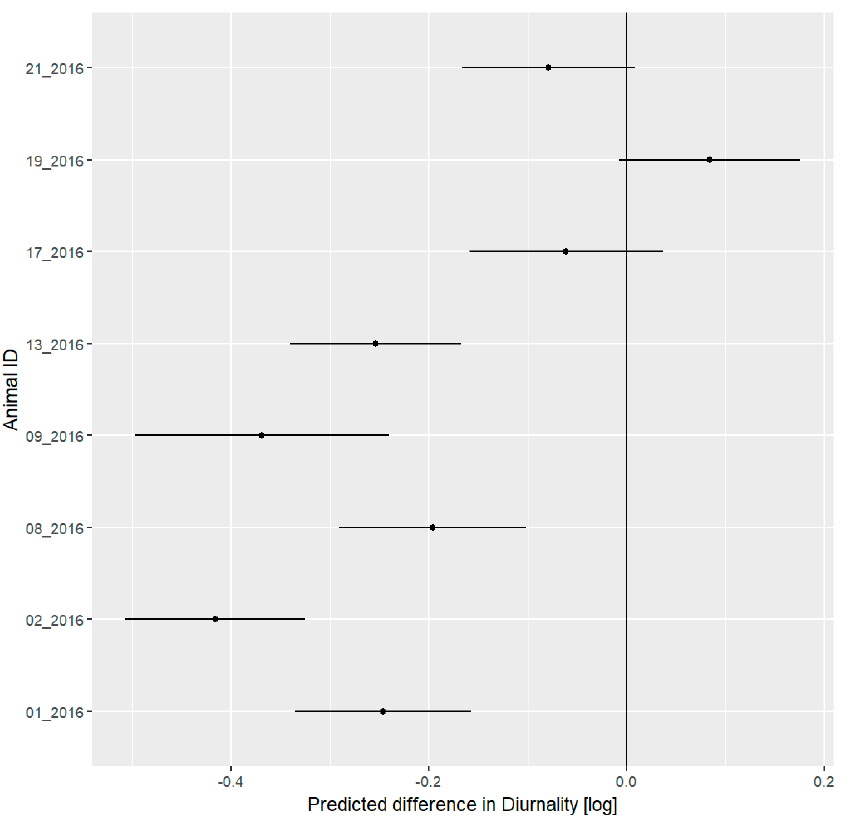
Figure 4. Mean predicted values with 95% confidence interval for differences in daily index of diurnality (DI) of eight hedgehogs between the pre-festival and festival phases. Negative values represent a decrease in the DI during the festival, while positive values represent an increase during the festival. These differences are log transformed. We consider all differences to be significant where the confidence interval does not include 0. Five out of eight individuals showed a significant decrease in the DI.